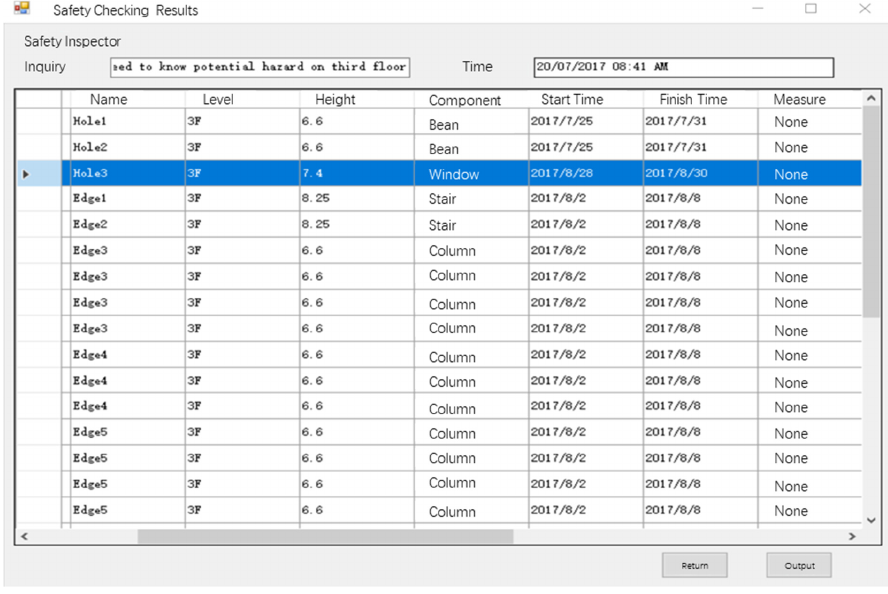
Figure 23. Safety risk query result for potential risks on the third floor.